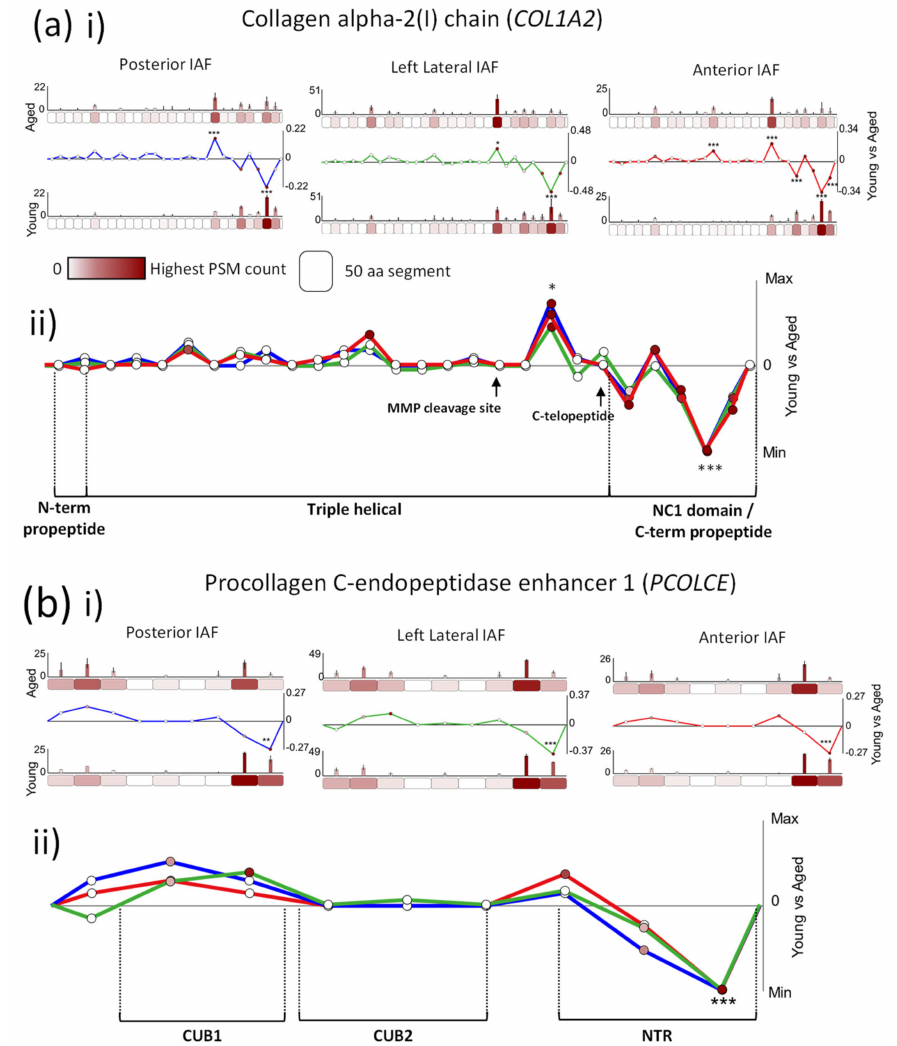
Figure 3. COL1A2 and PCOLCE protein structures exhibit differences in peptide yield patterns between young and aged proteins, which were conserved in posterior, left lateral and anterior IVD regions. PSMs were summed in each 50-aa protein segment, normalised and averaged for young and aged groups (bar graphs = average, normalised PSMs, error bars = standard deviation). Average PSMs per segment in young were subtracted by those in aged and divided by segment aa length (50) to reveal fluctuations in peptide yield along protein structures (line graph y axes = aged–young PSM counts/segment length, normalised between tissue regions in composite graphs; * p ≤ 0.05; ** p ≤ 0.01; *** p ≤ 0.001, Bonferroni-corrected, repeated-measures ANOVA; black * in composite line graph = significant in all three IVD regions; functional domains, sourced from UniProt, are indicated). (( a ), i) Several COL1A2 segments exhibited significant differences in peptide yield between young and aged samples within the C-terminal half of the protein (blue line: posterior, green: left lateral, red: anterior). (( a ), ii) Crucially, these differences in peptide yield along the COL1A2 structure are markedly consistent between all the three regions, with a similarly higher peptide yield displayed in segment 20 of aged compared to young and lower peptide yield in the last three segments, nearest to the C-terminus. (( b ), i) The last 50-aa segment on the C-terminal end of PCOLCE also exhibited a significantly lower peptide yield in aged compared to young for the inner AFs of all three IVD regions. (( b ), ii) Peptide yield difference patterns along the primary structure were also similar between all the three regions, with a consistently higher peptide yield in aged compared to young measured on the N-terminal side of the protein followed by a lower yield in the last two segments near the C-terminal